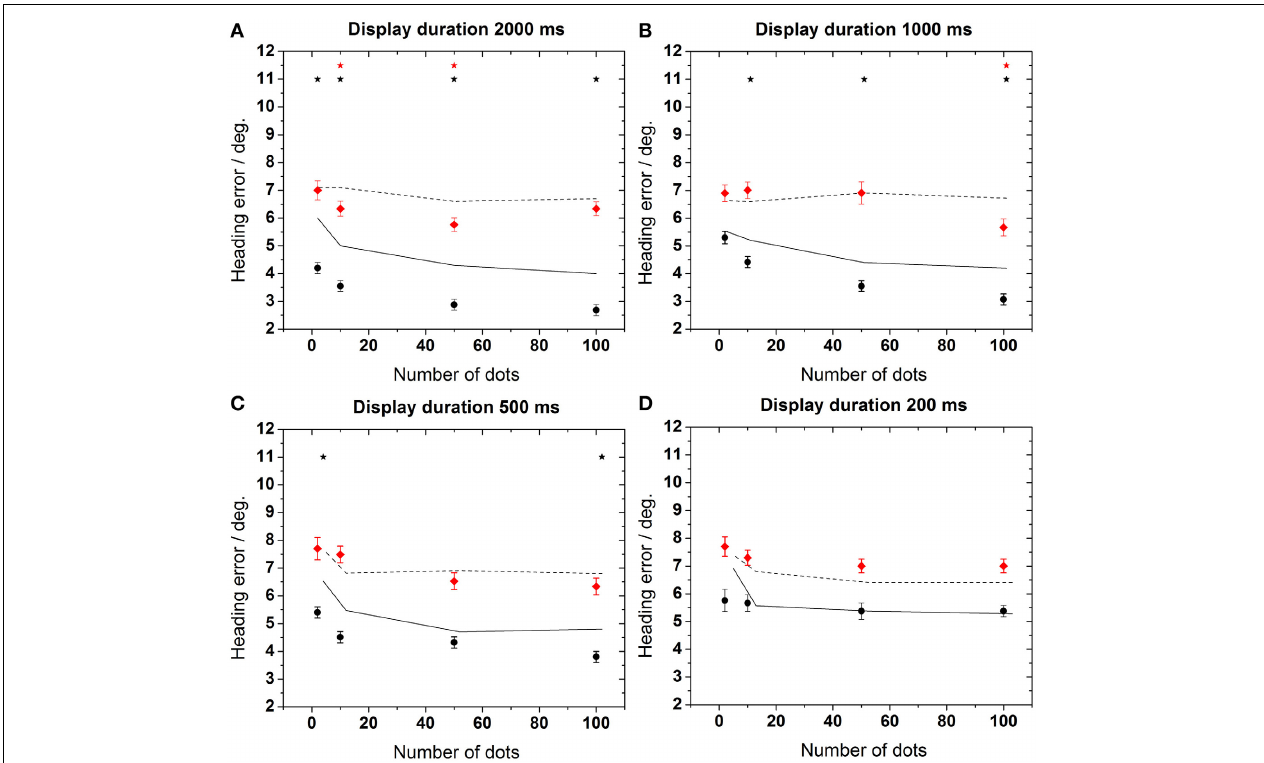
FIGURE 6 | Heading error as function of the number of dots during stereoscopic stimulation. The solid lines (control group) and dashed lines (test group) depict the results of Figure 4 (non-stereoscopic